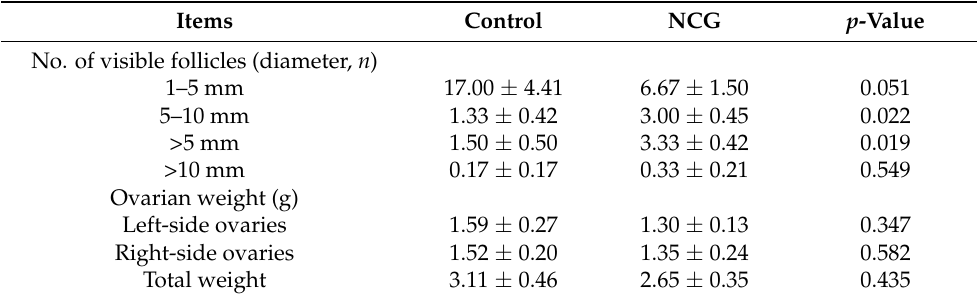
Table 1. The mean numbers of follicles in different size classes and weights of ovaries between the two groups.